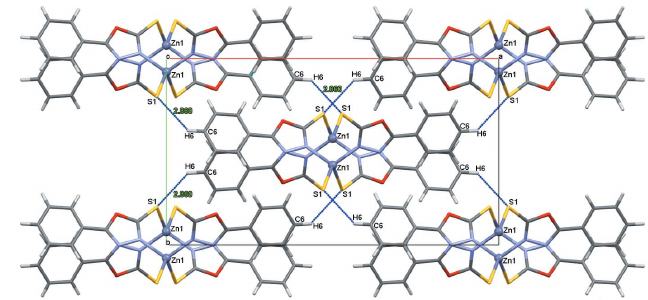
Figure 3 Crystal packing of the polymeric chains in the [(Zn L 2 ) n ] structure. The projection is along the [001] direction. Hydrogen bonds are shown by cyan